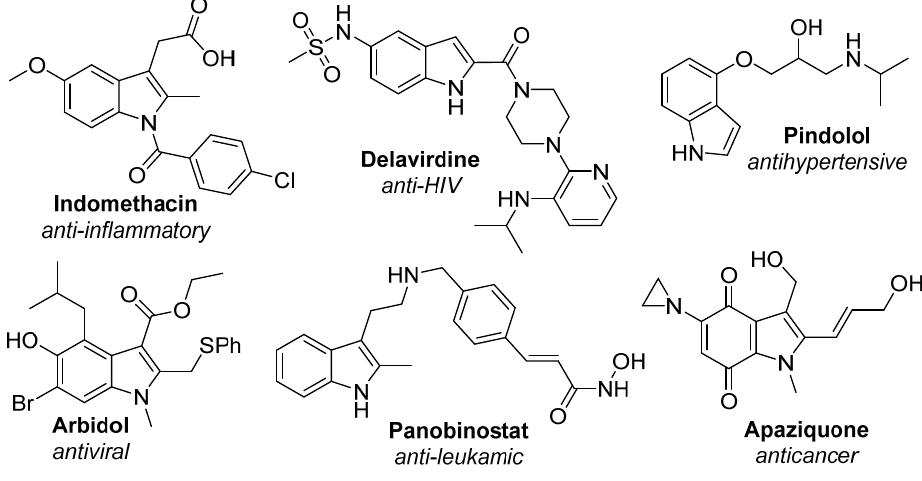
Figure 1. Indole based marketed drugs.